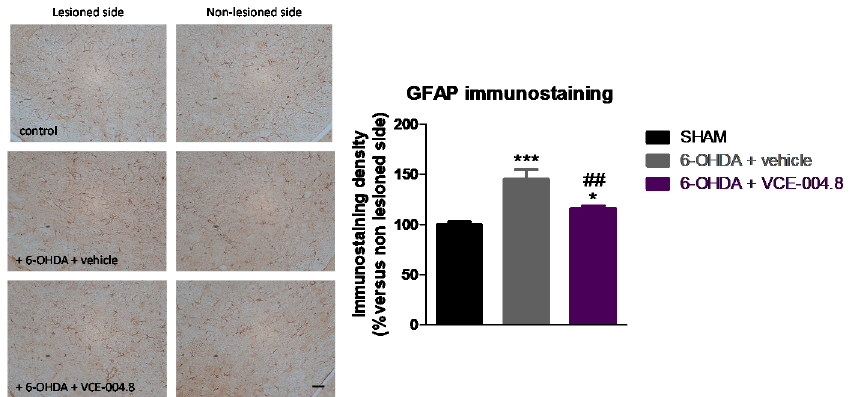
Figure 5. Intensity of the immunostaining for GFAP, a marker of astrocytes, measured in a selected area of the substantia nigra pars compacta of control (sham) mice and unilaterally 6-OHDA-lesioned animals treated with VCE-004.8 (20 mg/kg) or vehicle (Maisine CC/corn oil) given orally. Treatments were daily and prolonged for 2 weeks. Data corresponded to percentage of the ipsilateral lesioned side versus contralateral non-lesioned side at 24 h after the last dose and were expressed as means ± SEM of more than 5 animals per group. They were analyzed by one-way ANOVA followed by the Bonferroni test (* p < 0.05, *** p < 0.005 versus sham; ## p < 0.01 versus 6-OHDA + vehicle). Representative immunostaining images for each experimental group are shown in the left panels (scale bar = 50 µm).